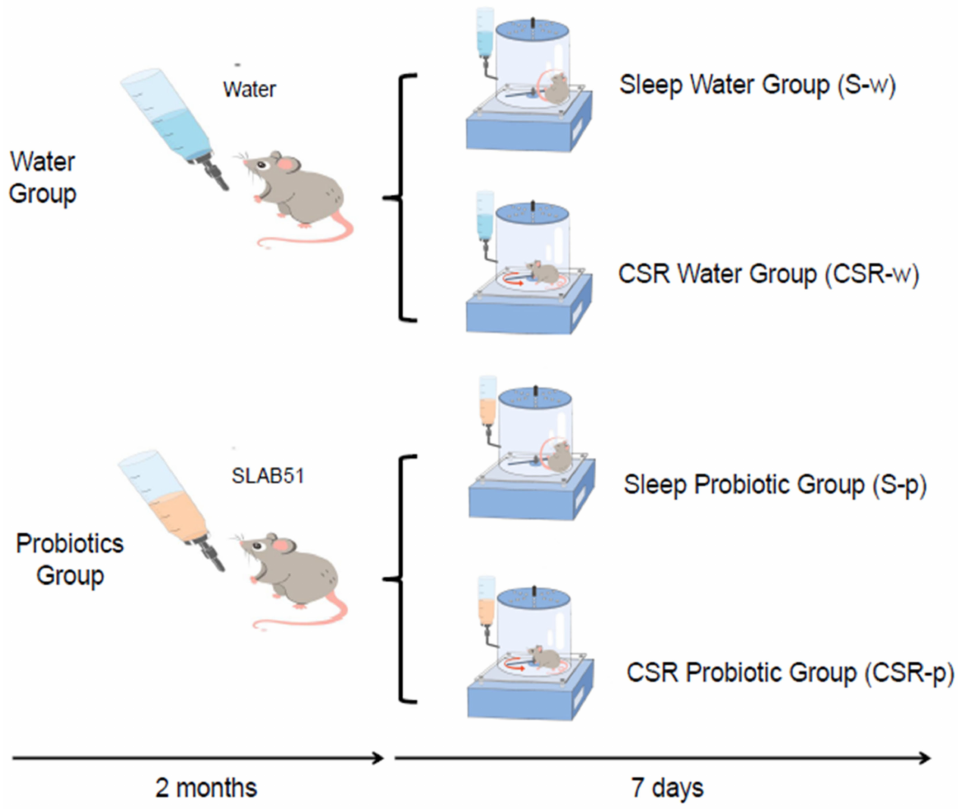
Figure 1. Experimental